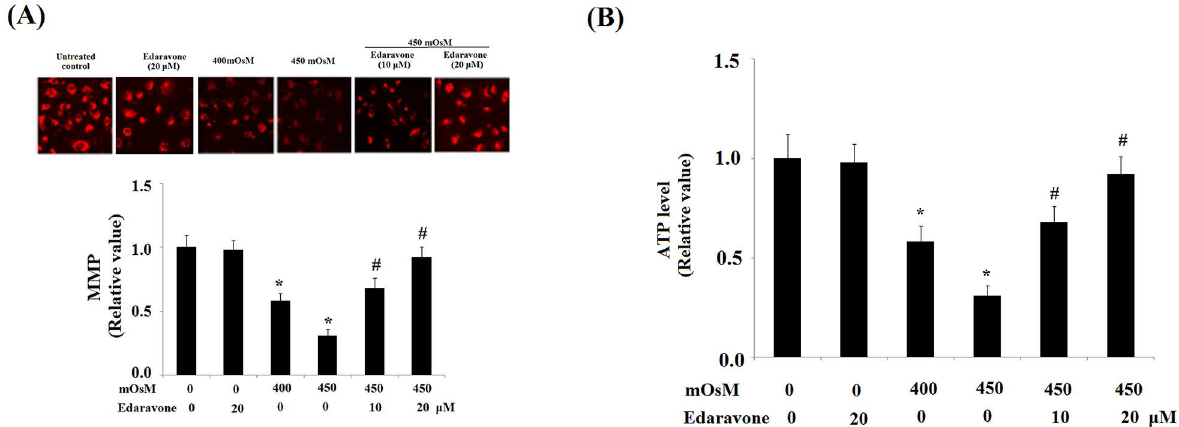
Fig 3. Effects of edaravone on mitochondrial function in primary HCEpiCs exposed to hyperosmotic media. (A) Representative fluorescence photos of mitochondrial membranepotential (MMP) show reducedintracellular MMP in primary HCEpiCs, which was ameliorated by edaravone in a dose-dependent manner; (B) Quantitative results show that exposureto hyperosmotic media (400–450 mOsM) reducedintracellularATP in HCEpiCs, which was attenuated by edaravonein a dose-dependentmanner(ANOVA: * , P < 0.001 vs. untreated control; #, P < 0.001vs. 450 mOsM treated group).